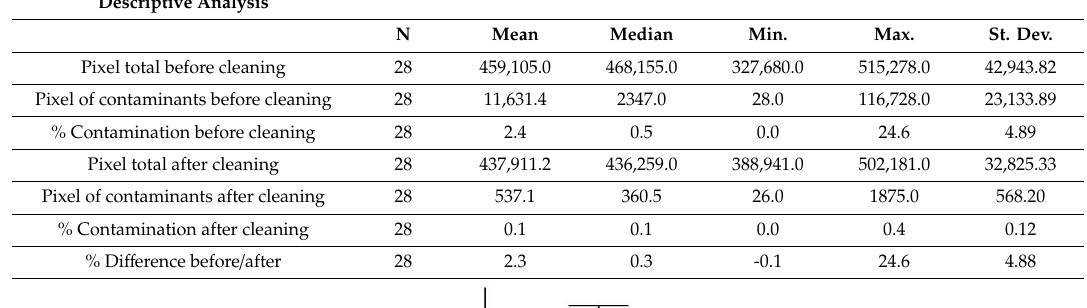
Table 6. Descriptive analysis; box plot of projected surface contamination of all abutment samples before and after cleaning in pixels and percent.